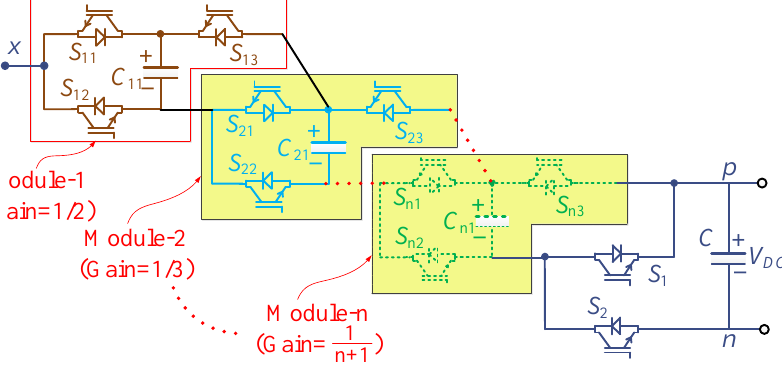
Figure 6. Modular structure of the proposed topology.